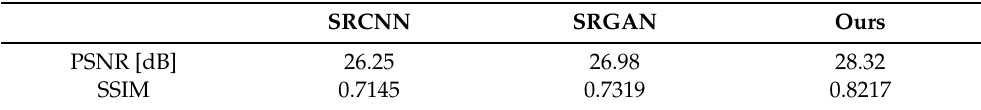
Table 1. Results of each model: Compared to ordinary methods using SRGAN [9] and SRCNN in previous works [15], the proposed method has higher scores both in PSNR and